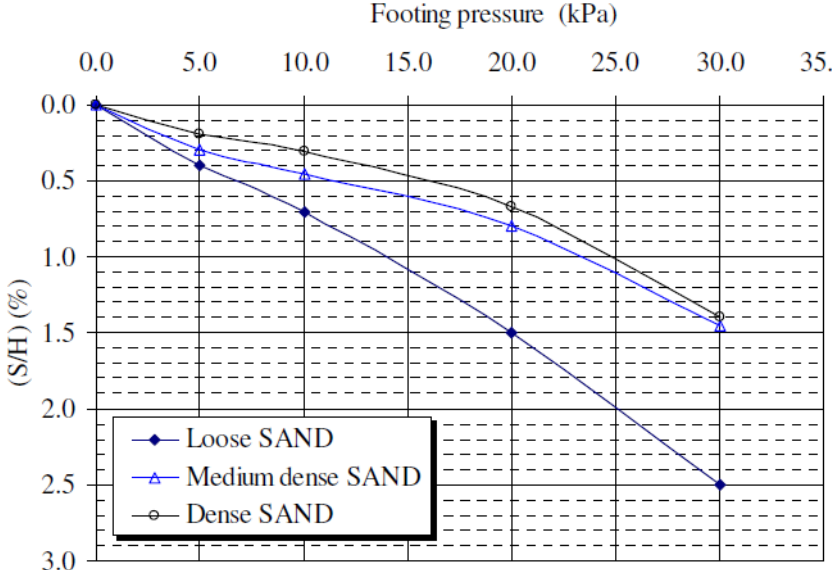
Figure 6. Influence of soil density on the settlement of the footing.